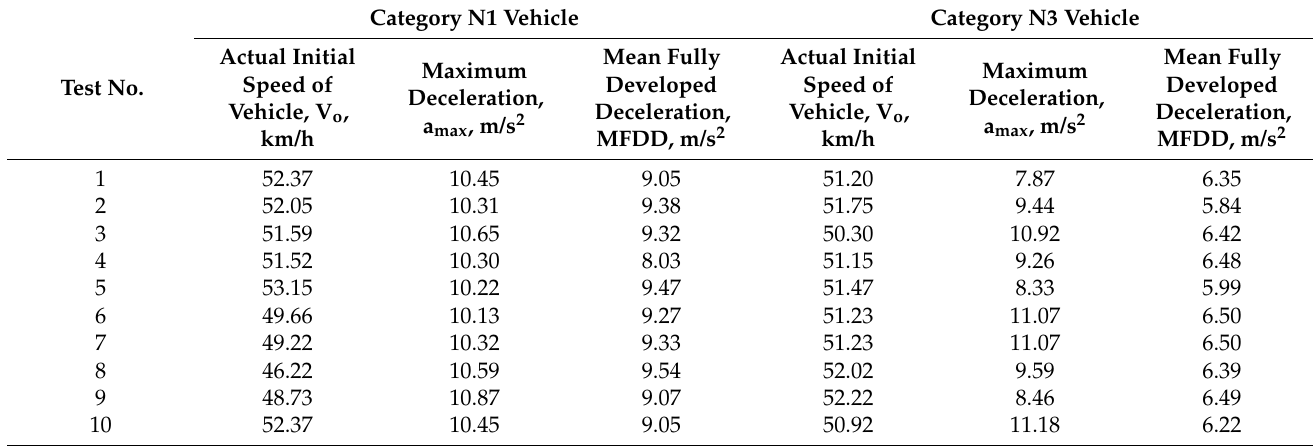
Table 4. Parameters of the braking process on a wet asphalt pavement from 50 km/h.